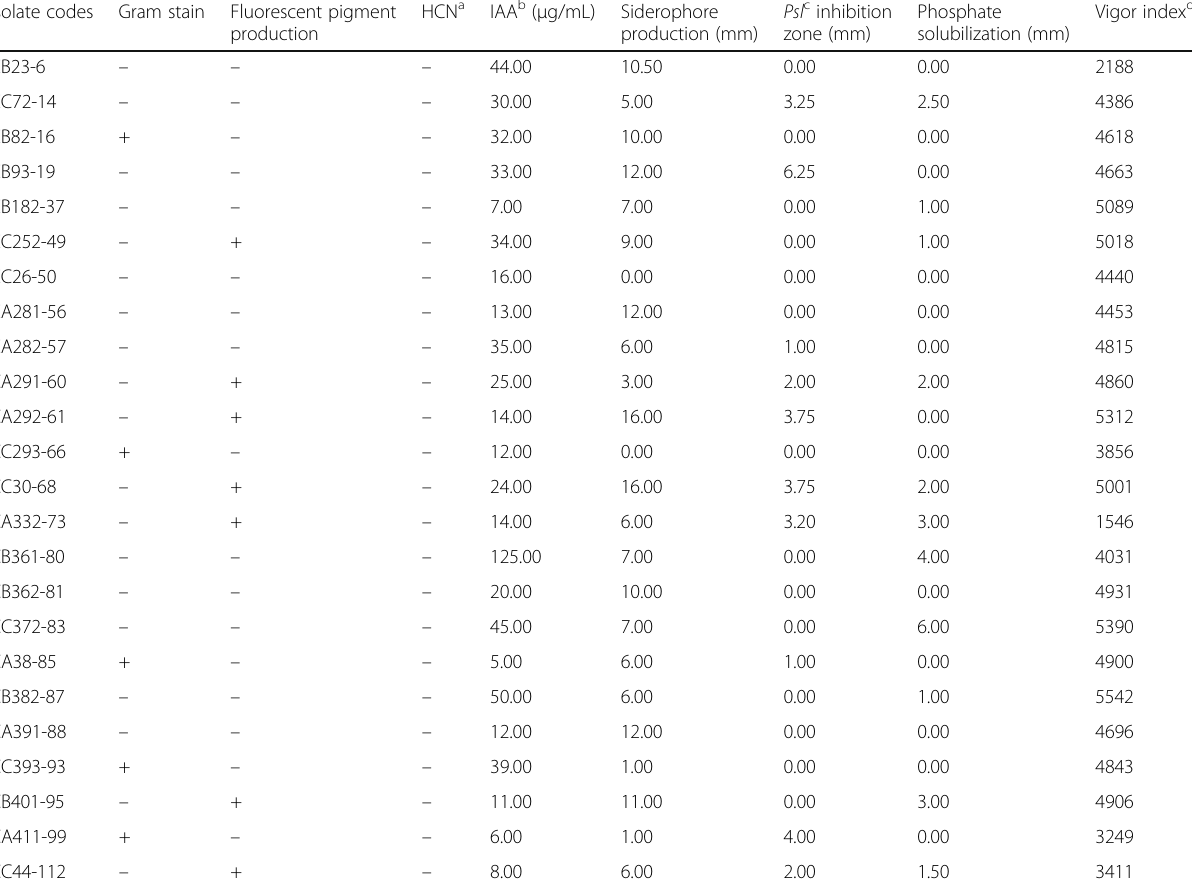
Table 1 Overview of in vitro biocontrol and plant-beneficial traits of selected endophytic bacteria and later used in our study Isolate